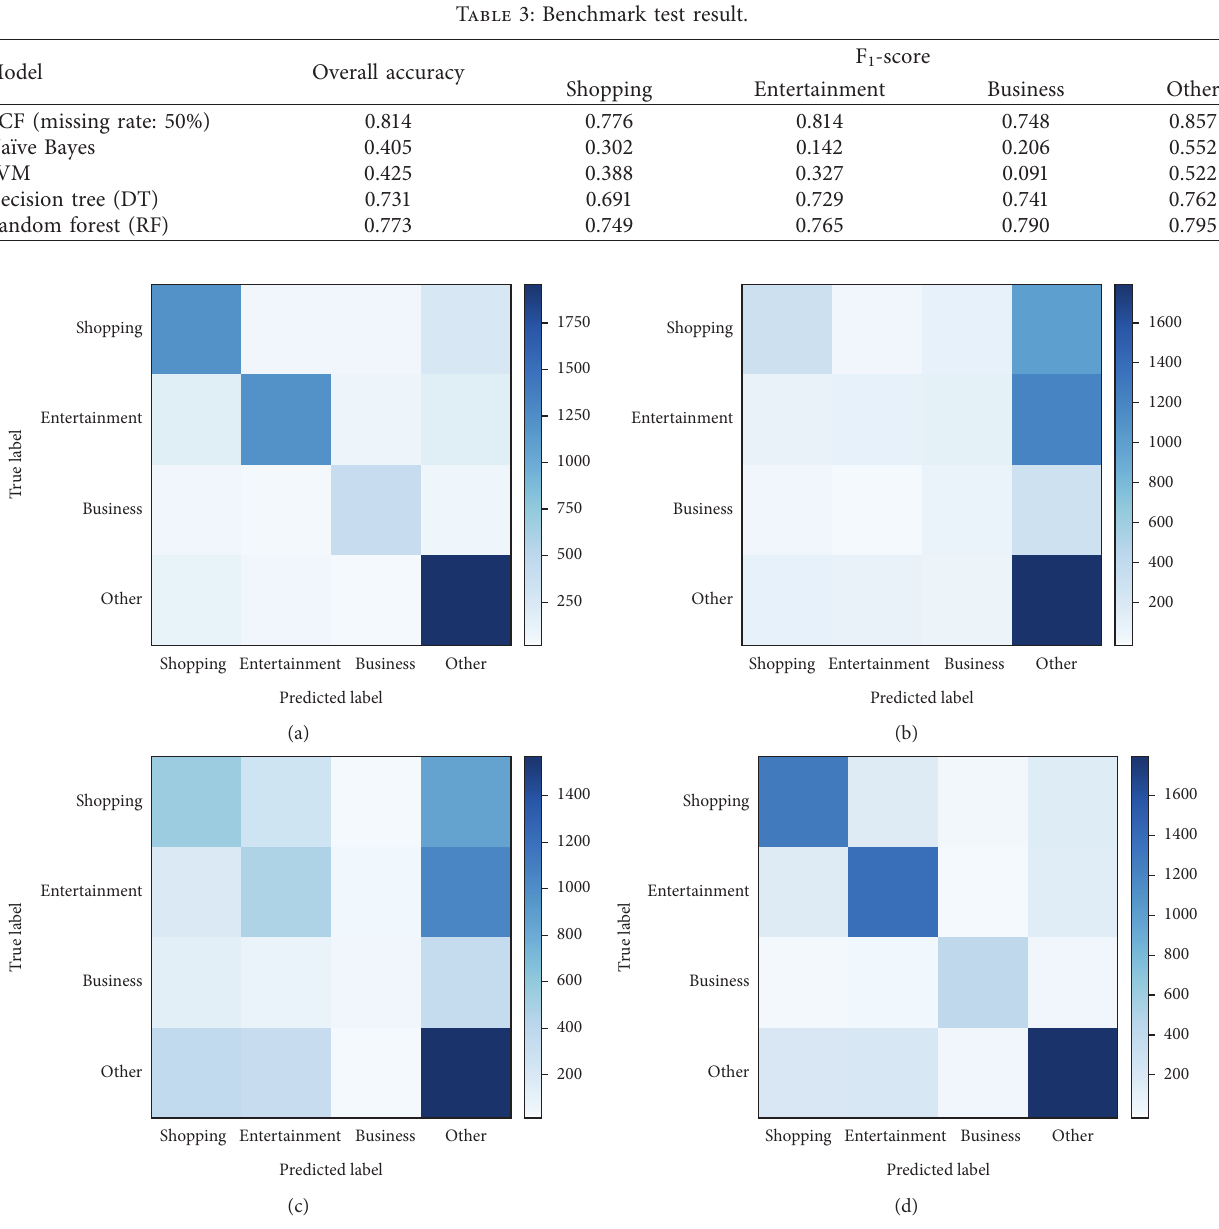
Figure 8: Confusion matrices of different models. (a) TCF (50% missing rate). (b) Gaussian Na ¨ ıve Bayes. (c) SVM. (d) Random